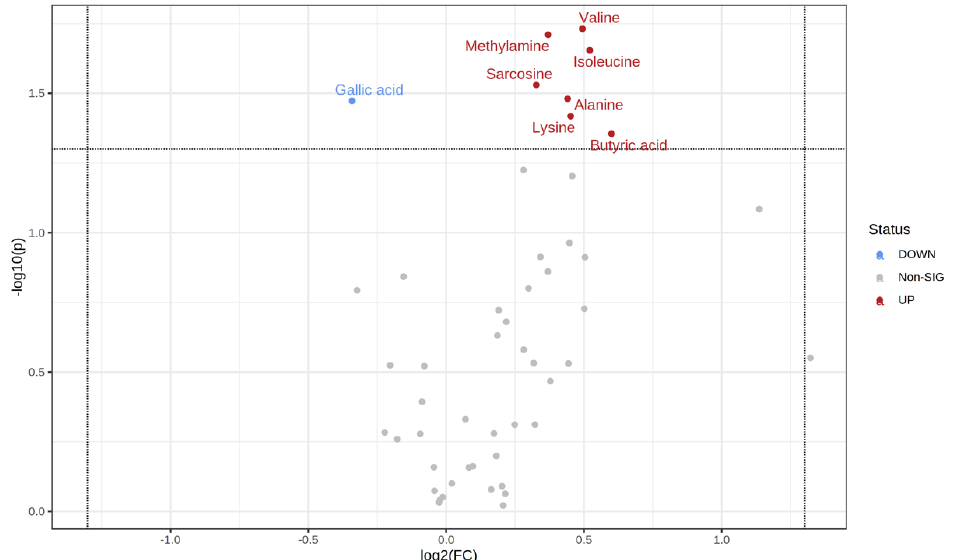
Figure 6. Volcano plot: Pairwise comparison placebo vs. probiotics time point t 2 in stool. The log 2 fold change ( x -axis) is plotted against the corresponding adjusted p -value ( y -axis). Thresholds for significance (adjusted p -value = 0.05; horizontal dashed line) and changes in concentration, vertical dashed lines, are shown. Significantly increased metabolites compared to probiotics at t 2 are displayed as dots in dark red on the right side. Significantly decreased metabolites compared to probiotics ( n = 28) are displayed as light blue dots on the left side. Upregulated features are displayed as red dots on the right side, whereas downregulated features are displayed as blue dots on the left side. Insignificantly altered metabolites are shown as gray dots.